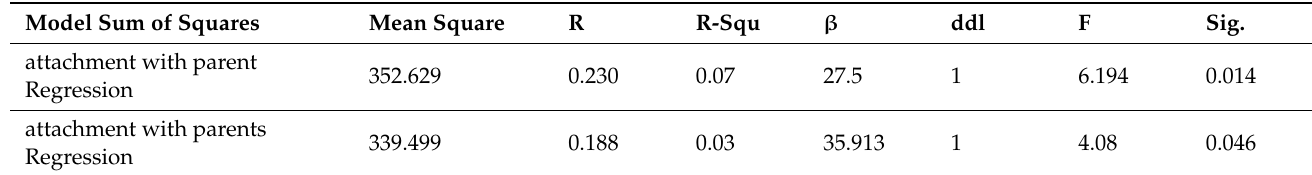
Table 2. Regression model